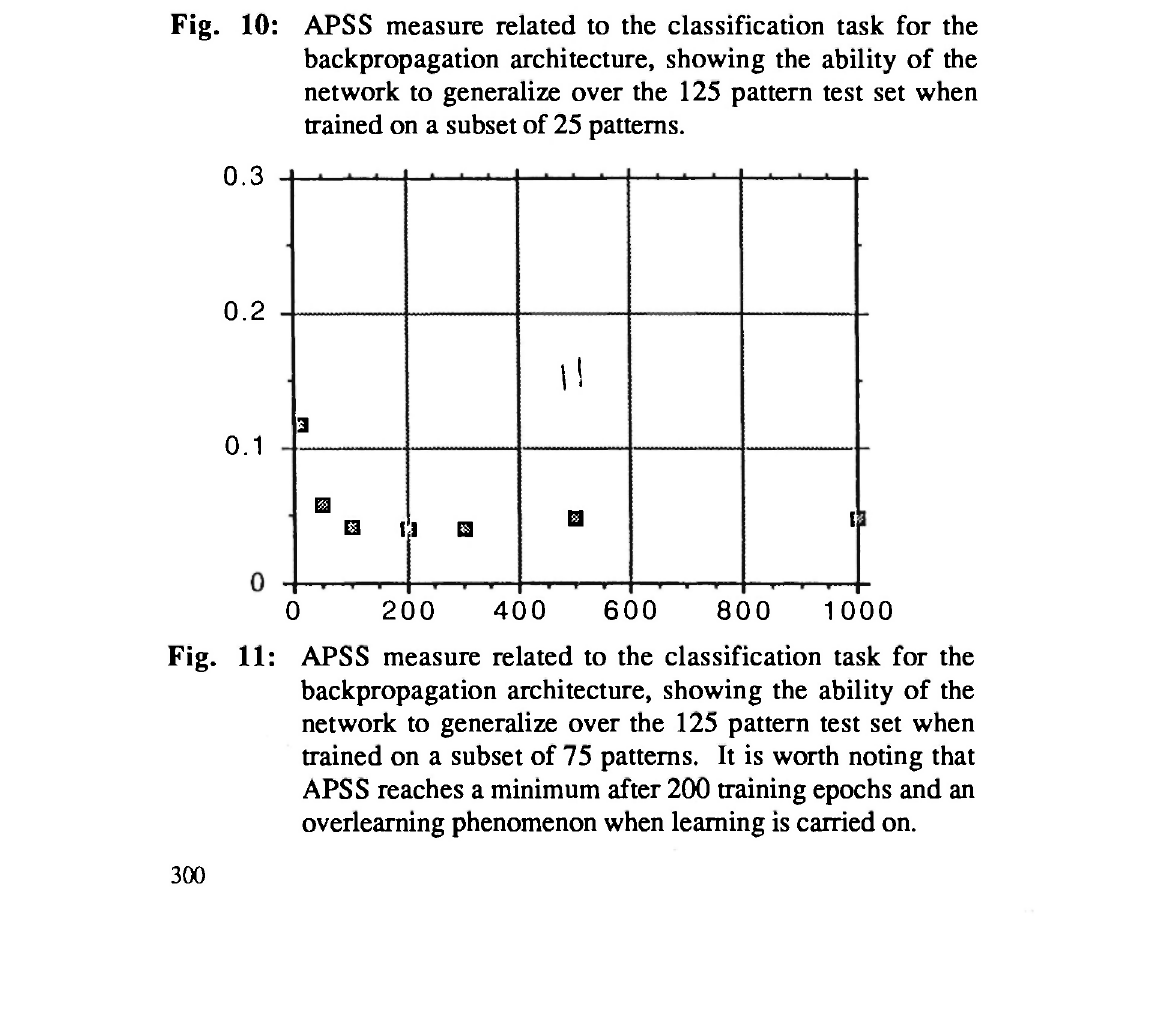
APSS measure related to the classification task for the backpropagation architecture, showing the ability of the network to generalize over the 125 pattern test set when trained on a subset of 25 patterns. 0.3